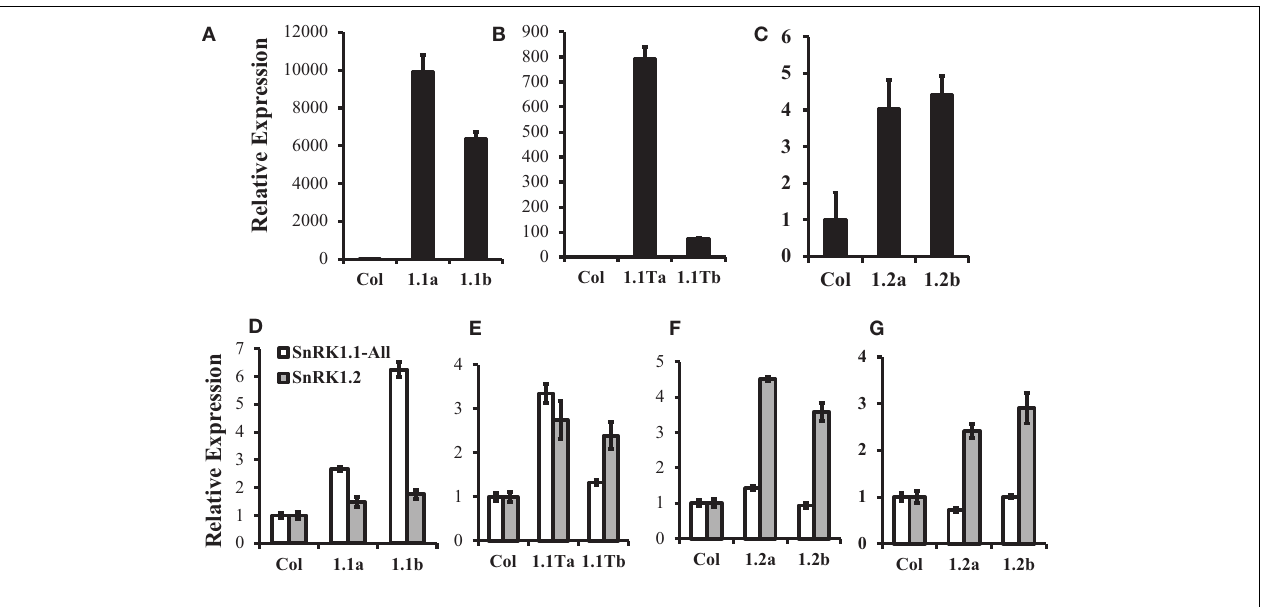
FIGURE 6 | Expression of Transgenes in SnRK1 transgenic plants. (A–C) Relative levels of GFP expression in 10d seedlings of wild type (Col), SnRK1.1-GFP, SnRK1.1T-GFP, and SnRK1.2-GFP. (D–G) Relative levels of SnRK1.1 and SnRK1.2 expression in the indicated